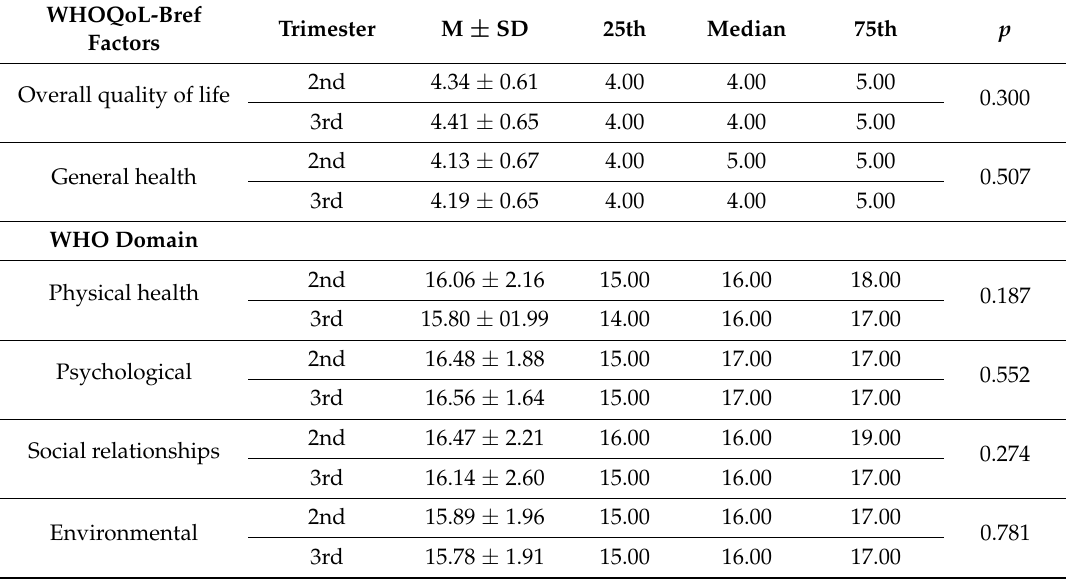
Table 2. Medians, 25th and 75th percentiles, means (M) and standard deviations (SD) for the Quality of Life-Bref Questionnaire (WHOQoL-Bref) and intergroup comparisons (2nd and 3rd trimesters) using the Mann–Whitney U-test.